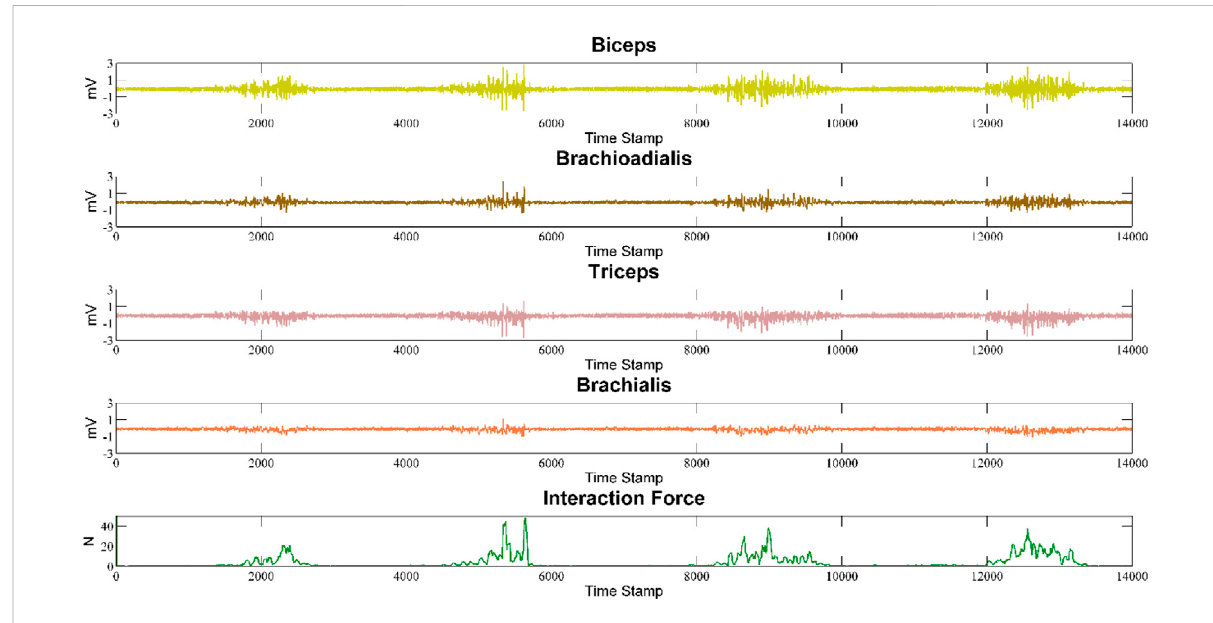
FIGURE 8 The raw EMG signal of the four channels and measured force.